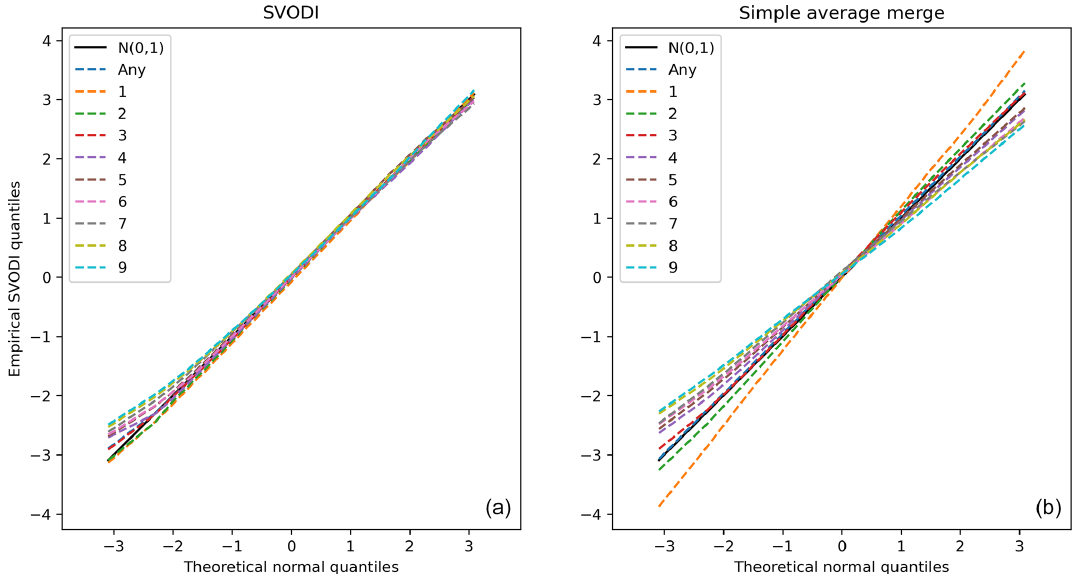
Figure 5. Quantile–quantile (QQ) plots for different numbers of input observations. For example, 3 shows the quantiles of all SVODI values where three input indices contributed. Any shows the quantiles for any number of observations. N( 0 , 1 ) , the diagonal, shows the theoretical normal distribution for comparison. (a) The QQ plot of SVODI. (b) For comparison the quantiles of an index generated by simple